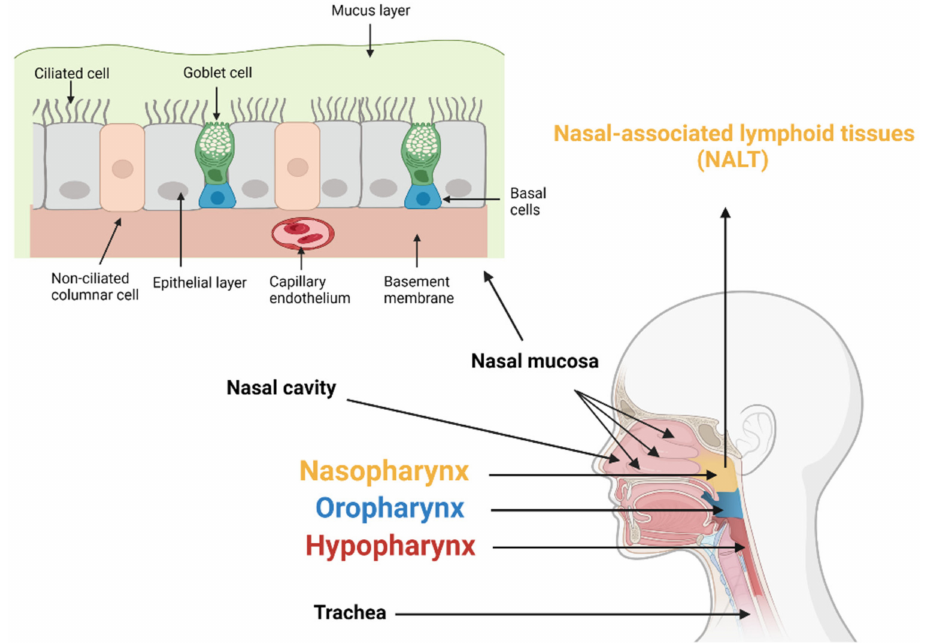
Figure 1. Schematic diagram of the nose, including the main cell types, and characteristic absorp- tion